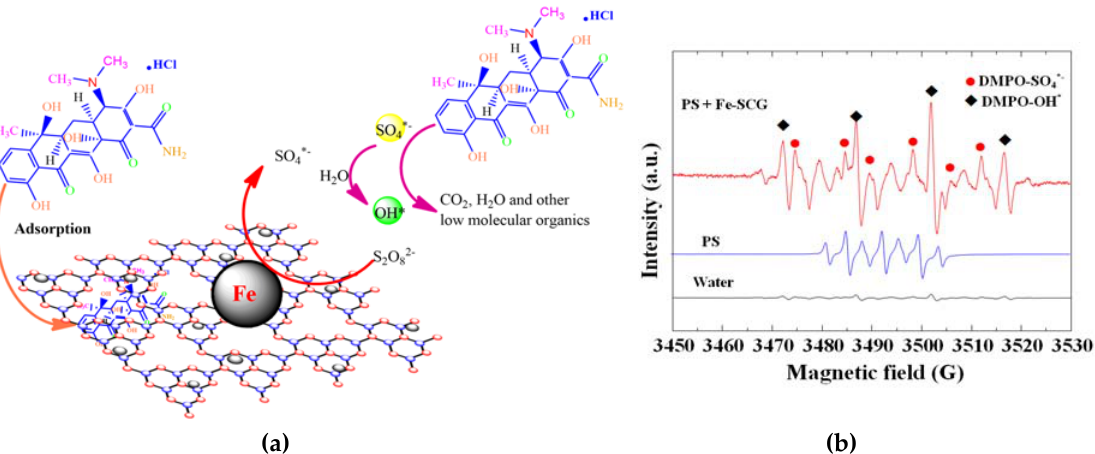
Figure 7. A proposed mechanism of TC degradation by Fe ‐ SCG catalyst in the presence of persulfate ( a ), electron paramagnetic resonance (EPR) spectra generated in the presence of 5,5 ‐ dimethylpyrroline ‐ oxide (DMPO) + water, DMPO + PS, DMPO + PS + Fe ‐ SCG ( b